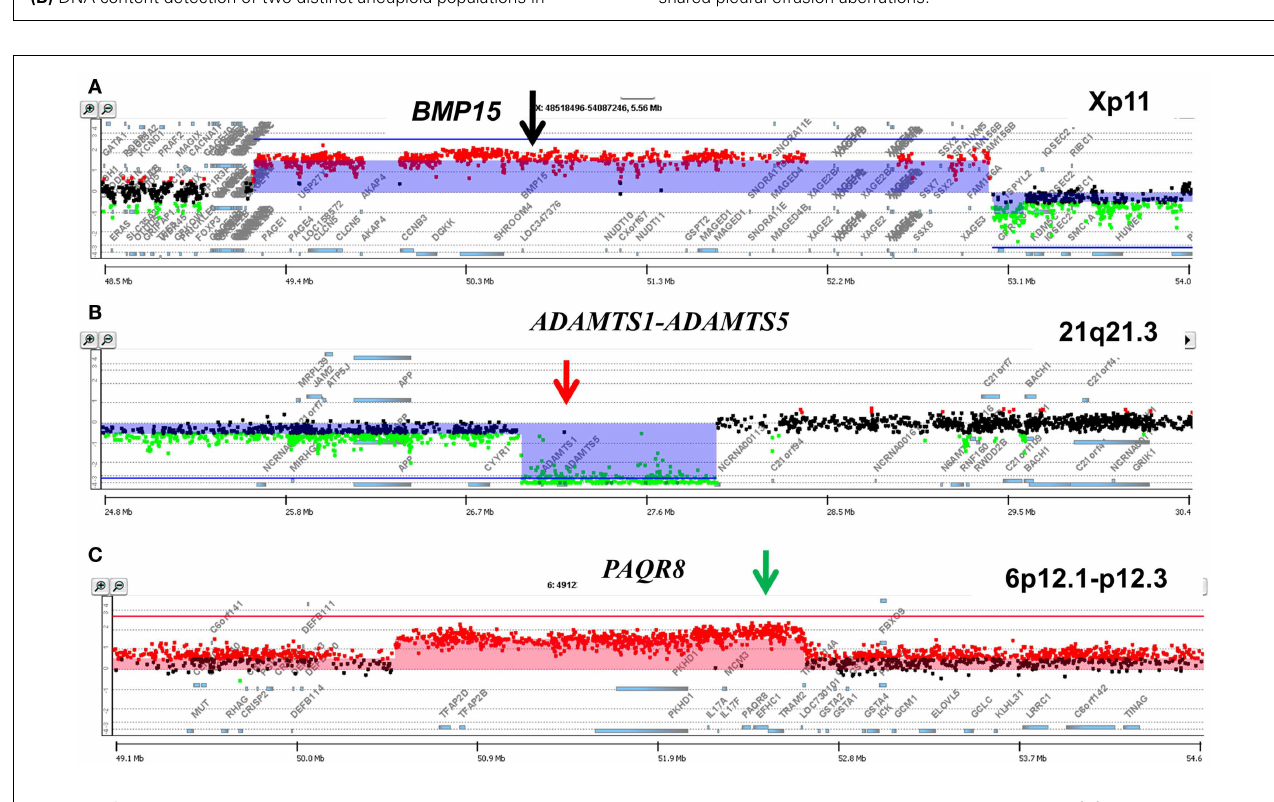
FIGURE 7 | Genomic aberrations and clonal analysis of matching metachronous primary ovarian tumor and pleural effusion. (A) Chromosome X11p focal amplicon and BMP15 . (B) Chromosome 21q21.3